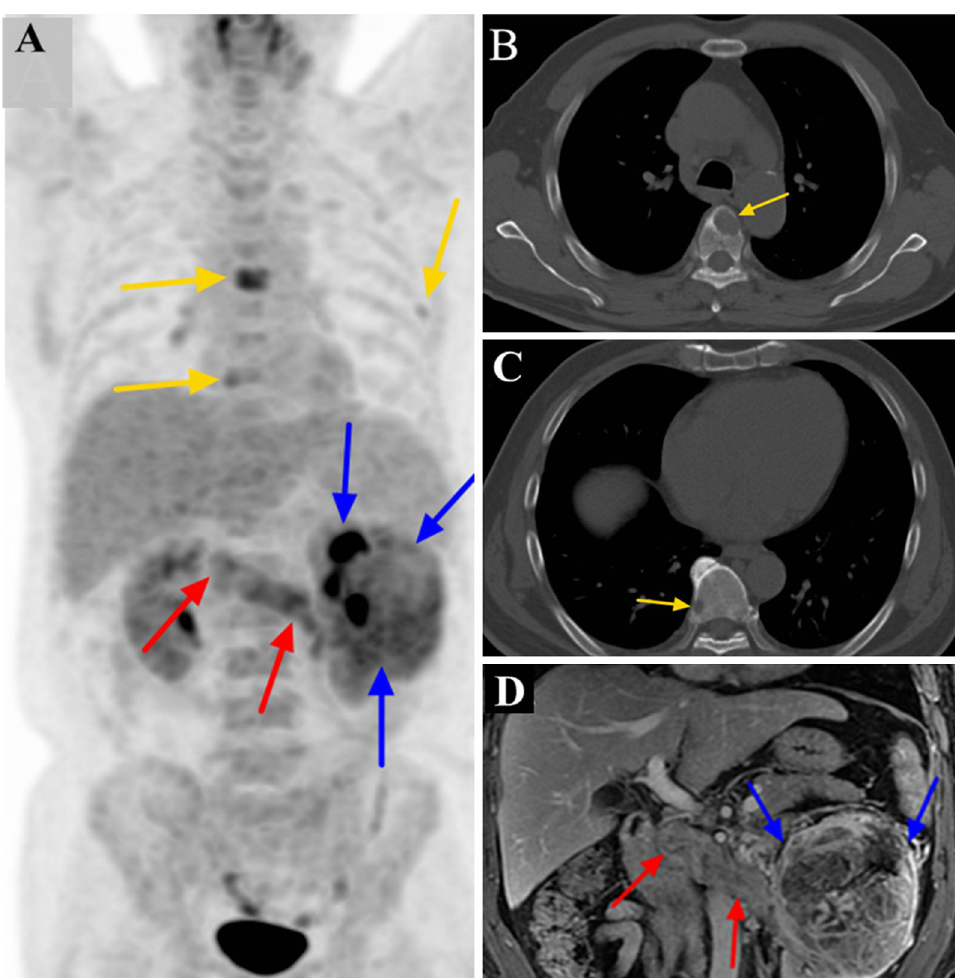
Figure 4. 18 F-FDG PET/CT and contrast-enhanced MRI (CEMRI) scans of a 59-year-old man with clear cell carcinoma of the left kidney associated with a level II venous tumour thrombus (VTT). The VTT invaded the venous wall and was graded as level II by both PET/CT and CEMRI. The site of diffusely increased FDG uptake (SUVmax 4.3) on a PET maximum intensity projection image is the primary tumour (blue arrow) ( a ). The site of pathologically increased FDG uptake (SUVmax 4.5) on the PET image from the left renal vein to the inferior vena cava is the VTT (red arrow) ( a ). Some bone metastases in the thoracic vertebrae and a left rib showed increased focal FDG uptake (yellow arrow) ( a ) with lytic lesions on selected axial CT slices (yellow arrow) ( b , c ). The VTT did not show homogeneous enhancement and completely occluded the lumen of the inferior vena cava on coronal CEMRI (red arrow) ( d ). The primary tumour showed heterogeneous enhancement (blue arrow) ( d